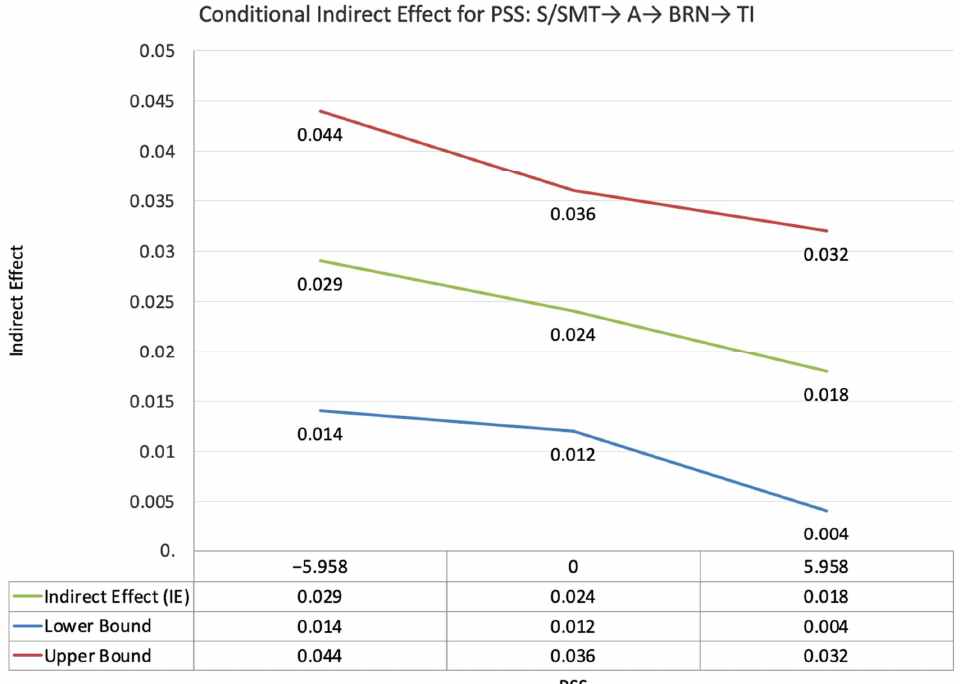
Figure 6. Conditional indirect effects of the difference between self-PMIEs compared to the control group on turnover intentions at low, average and high levels of perceived supervisor support, through autonomy satisfaction and burnout.